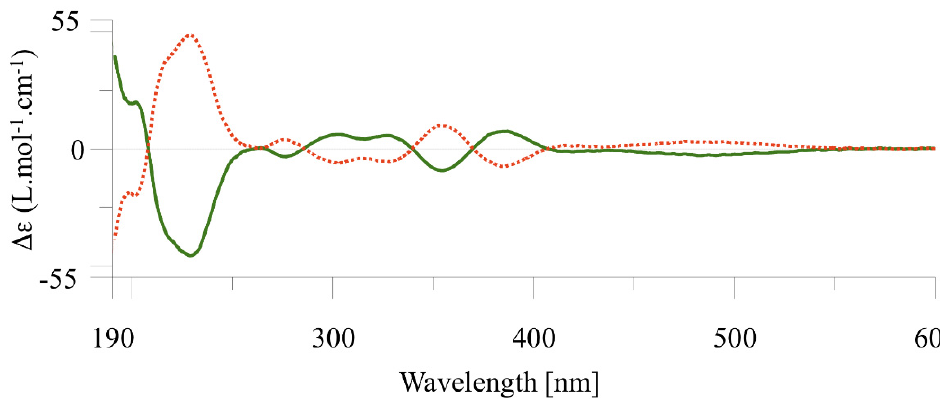
Figure 3. CD spectra of S - 3 (green) and R - 3 (red) recorded in CH 3 CN at 0.24 mM.